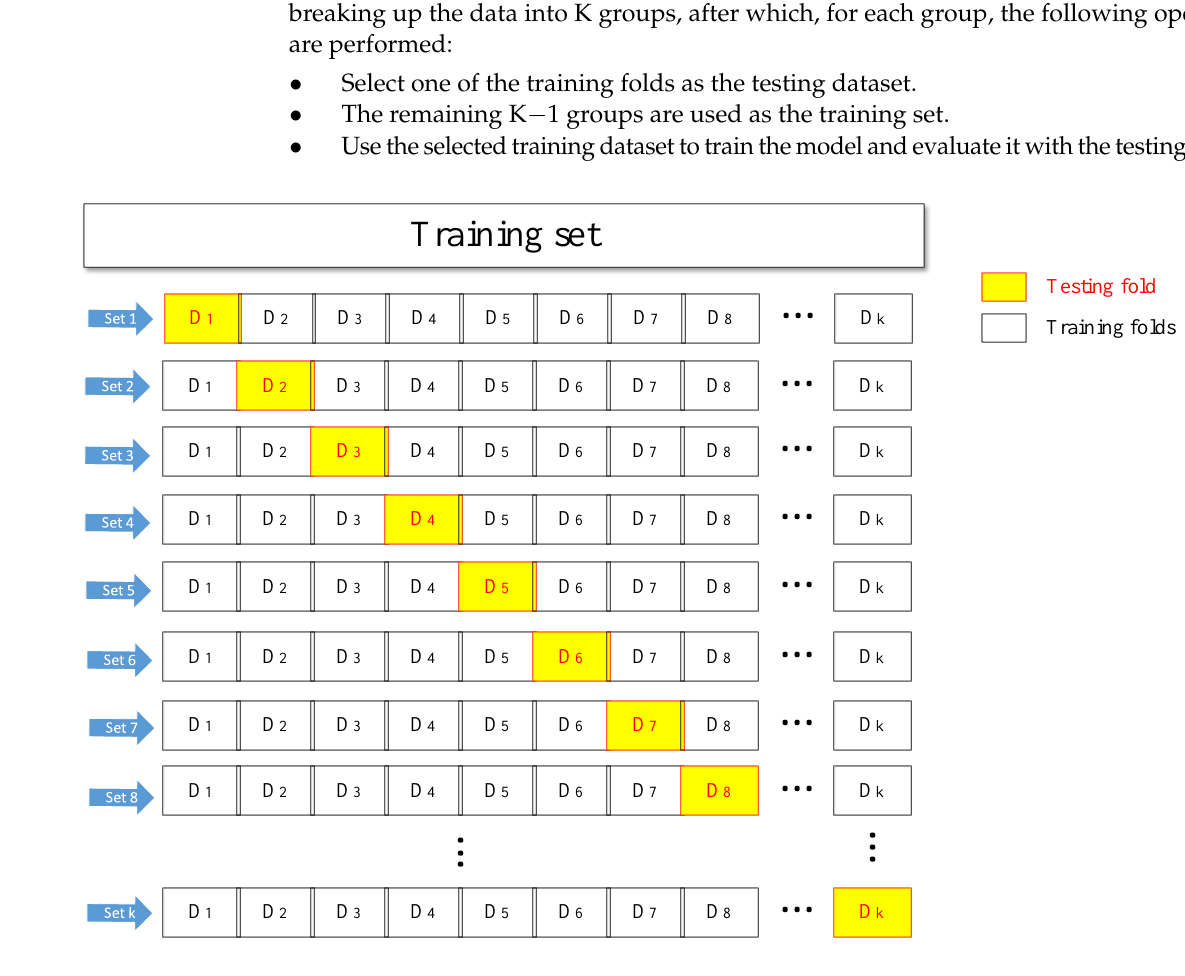
Figure 3. T he main process of K-fold cross-validation. Figure 3. The main process of K-fold cross-validation. In a small sample dataset of this work, k is usually set as 10, which is an empirical value obtained through extensive experimental trials. Directly utilizing the neural network simulation results in low bias and modest variance of the outcome. Therefore, in this simulation, the comprehensive datasets were randomly divided, with the first 170 sets selected as the training set and the last 70 sets as the testing set. Then, 170 samples were divided into 10 training folds. In addition, a different testing fold from D1 to D10 was selected each time as the validation set. Afterward, these 10 sets of data were inputted into the BP neural network model sequentially. The inaccuracy of the model evaluation caused by the accidental division of the sample datasets can be excluded via 10-time